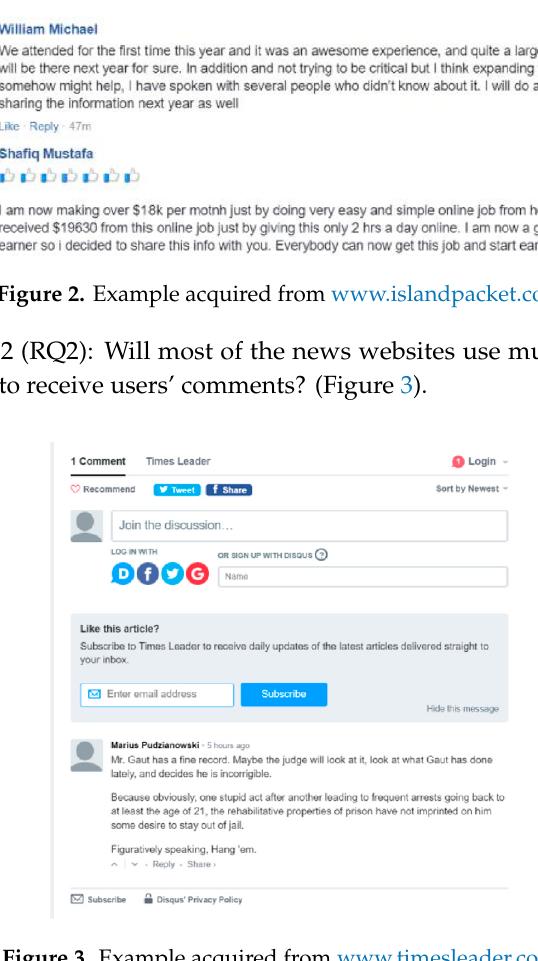
Figure 3. Example acquired from www.timesleader.com.